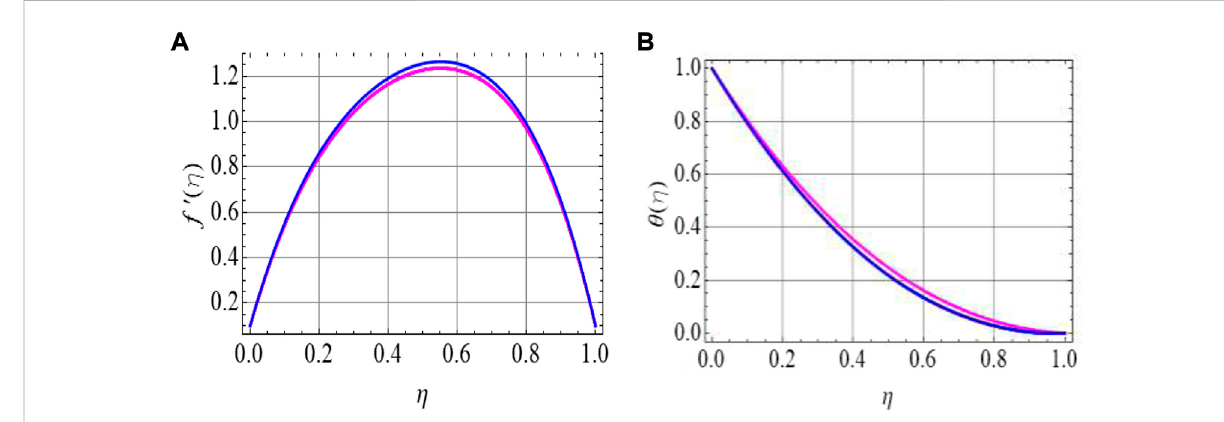
FIGURE 11 Validation of the current study with established results.